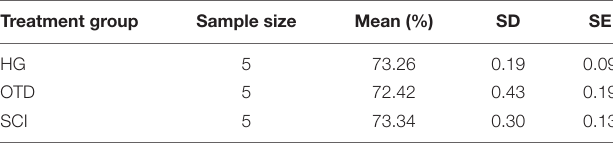
TABLE 2 | Summary on water content in the three treatment groups.